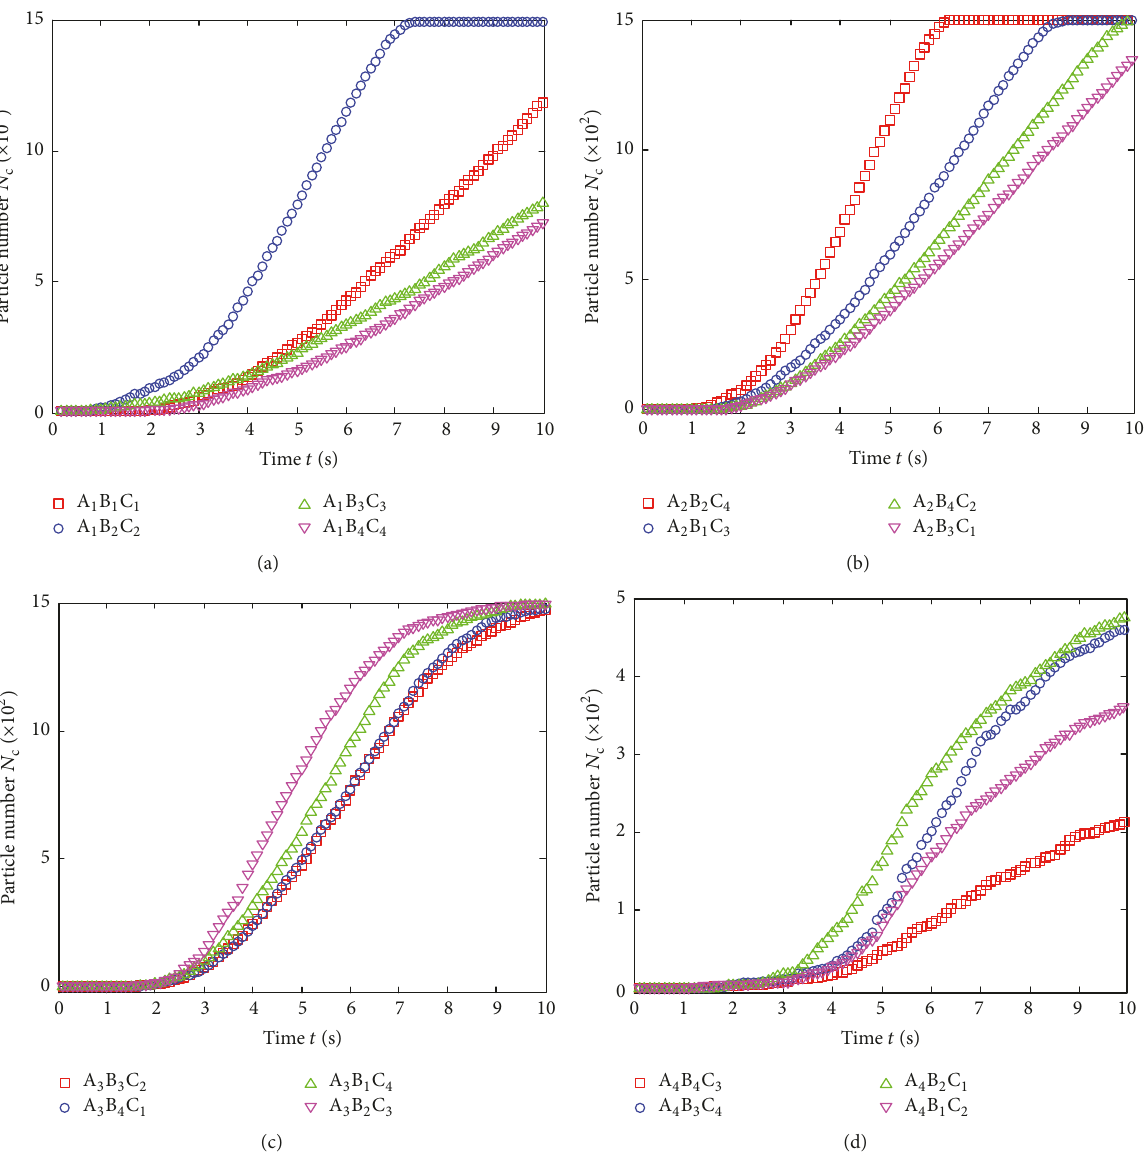
Figure 7: Relationship between the discharged particle number and vibration time in each subsimulation: (a) 𝑒 p = 0.7, and (d) 𝑒 p = 0.9. - t